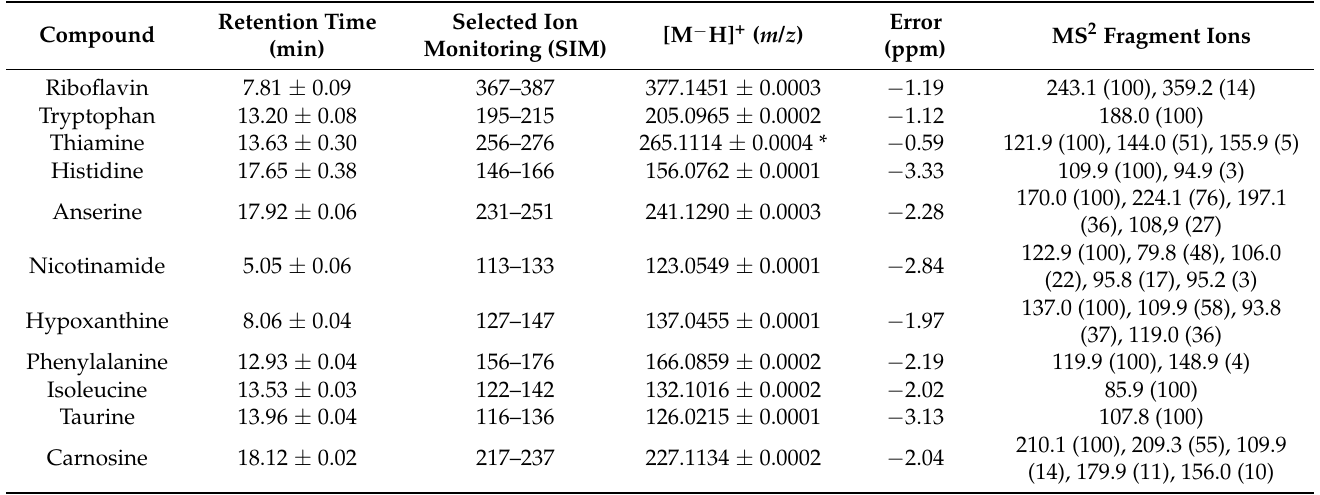
Table 1. Chromatographic and MS parameters for the mixed standard solution. Retention time and m / z values are shown as arithmetic means ± SD (n =